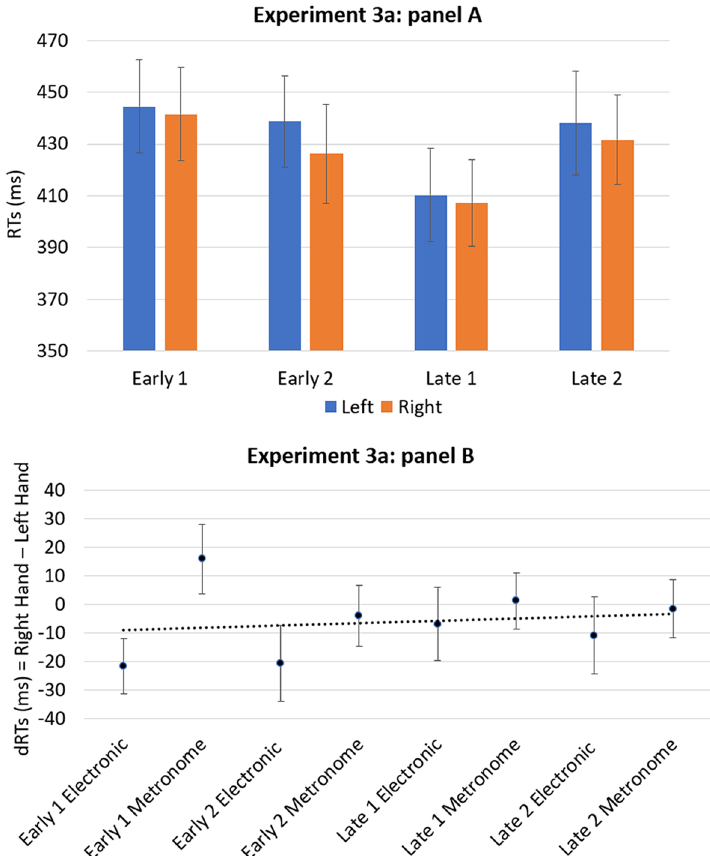
Figure 3. The panel ( A ) shows the mean of response times of the left and right hands for the four onset timing of the target (early 1, early 2, late 1, late 2). The panel ( B ) shows the mean dRTs (right key–left key) for each condition of the target. Positive differences indicate faster left-key responses; negative differences indicate faster right-key responses. Errors bars indicate standard error of the